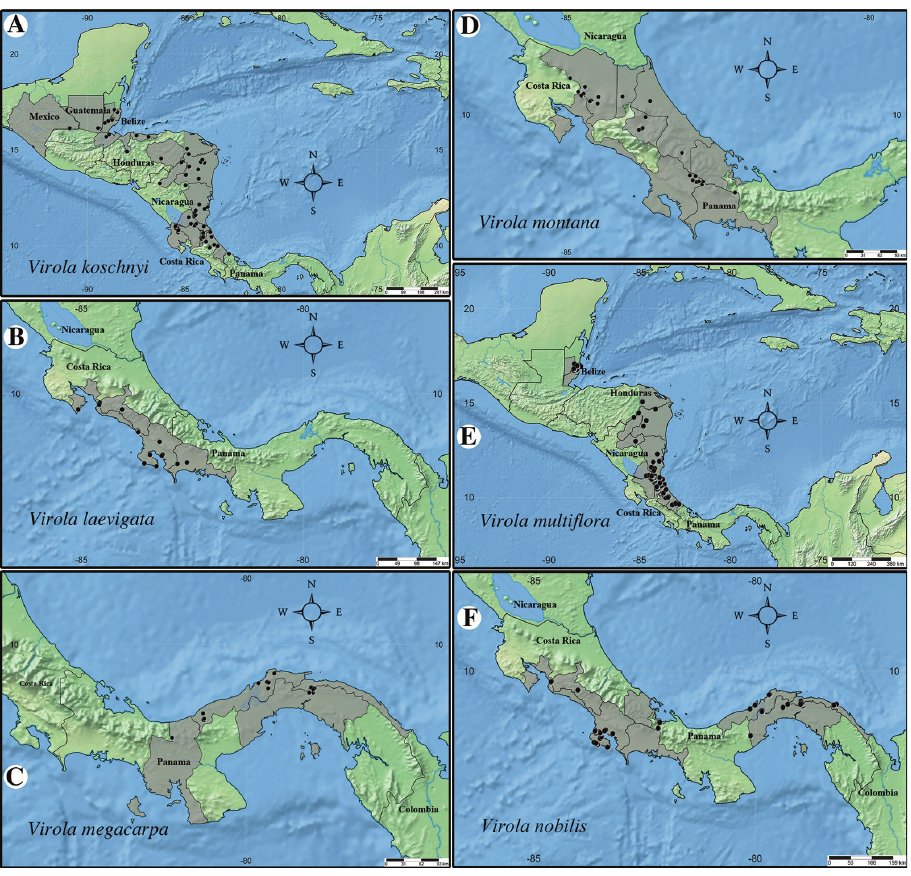
Figure 18. Geographic distribution of Virola koschnyi ( A ), V. laevigata ( B ), V. megacarpa ( C ), V. montana ( D ), V. multiflora ( E ) and V. nobilis ( F